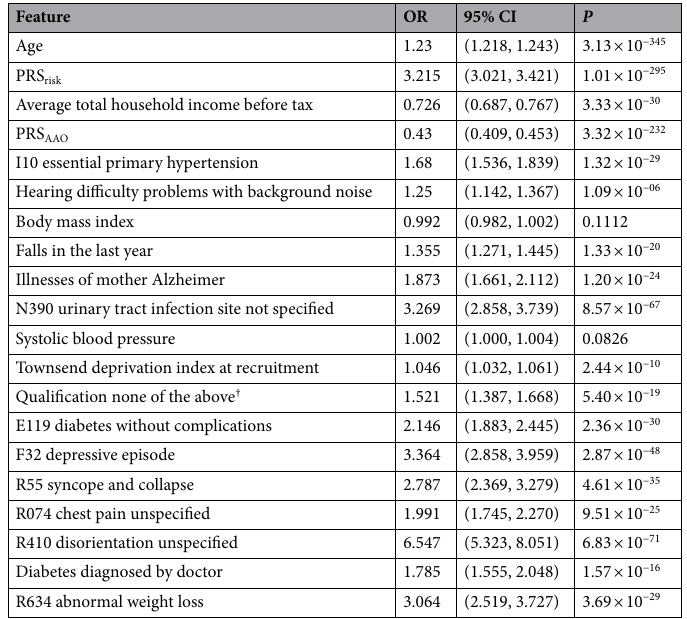
Table 3. Logistic regression for the top 20 features from XGBoost (age 40 +). Single-feature logistic regression with adjustment for age and sex. OR odds ratio. † None of the following: college or university, A levels/AS levels, O levels/GCSEs, CSEs, NVQ or HND or HNC, other professional qualifications, e.g. nursing and teaching.